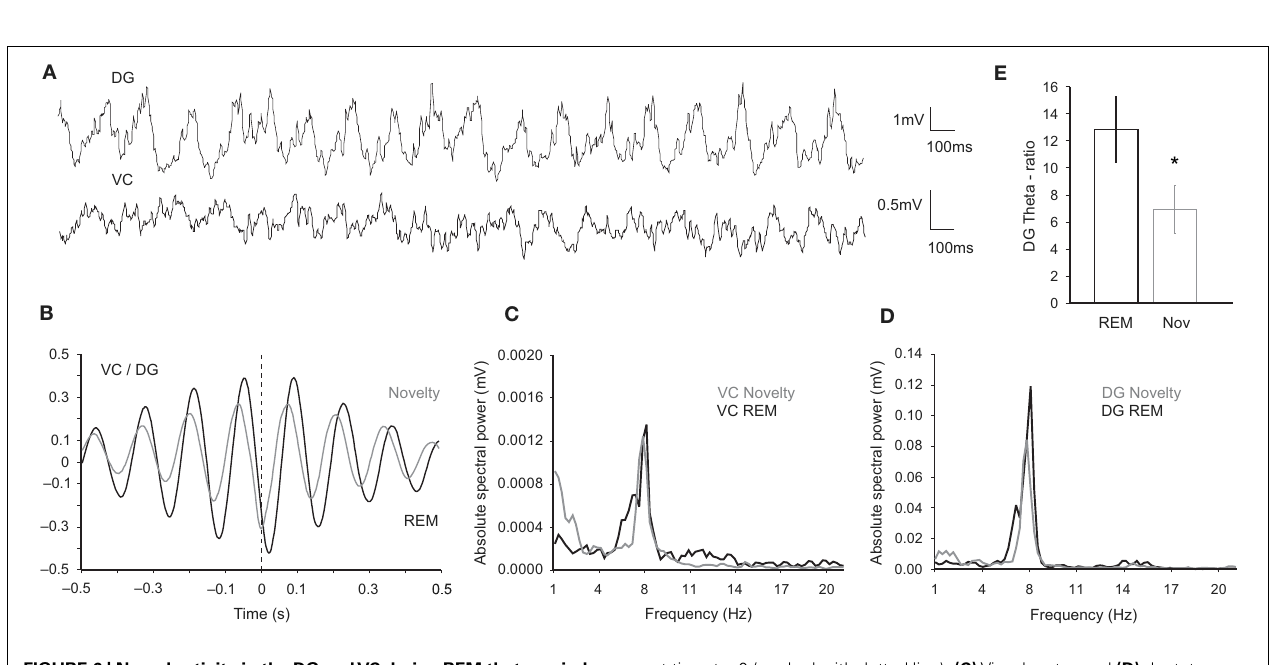
at time t = 0 (marked with dotted line). (C) Visual cortex and (D) dentate gyrus spectral power examples during the REM (black trace) and the novelty (grey trace) periods. Higher values for DG, but not for VC are detected during the REM theta periods. Note the appearance of additional small theta peak in the range of 7 Hz for the REM theta periods. (E) Theta-ratio in the REM period (black bars) is higher in comparison to the novelty (grey bars) values; * p <